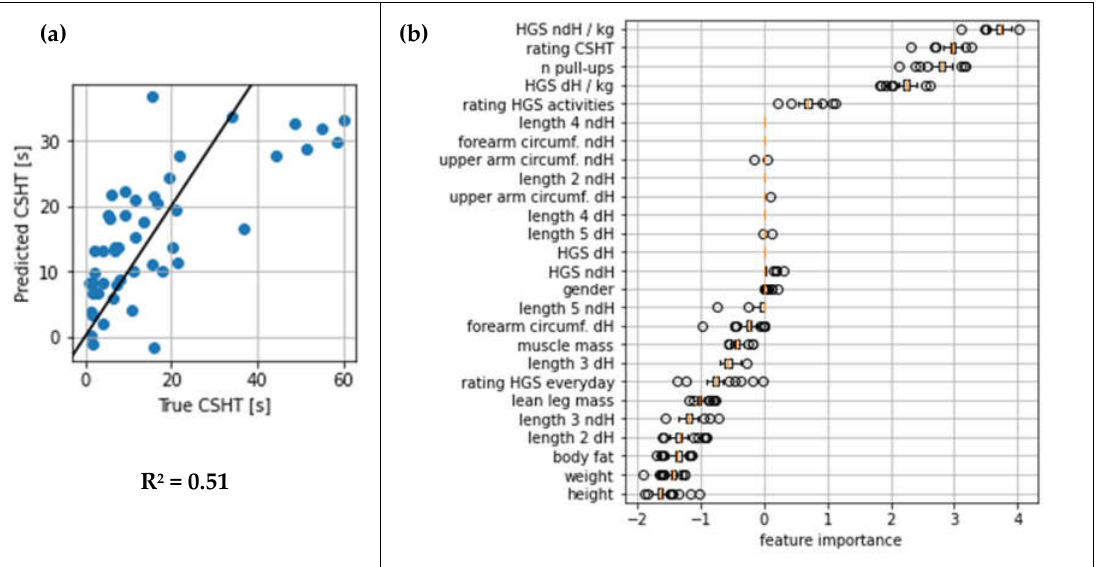
Figure 3. Results of the elastic net model. ( a ) True vs. predicted values for the CSHTS, as well as fit line for perfect fit. ( b ) Boxplots sorted according to the median coefficients (feature importance scores) of the features in the elastic net model during LOGO. Negative values represent an effect of high feature values reducing the CSHT; positive values represent an effect of high feature values increasing the CSHT. Please refer to Table 2 for feature labels.